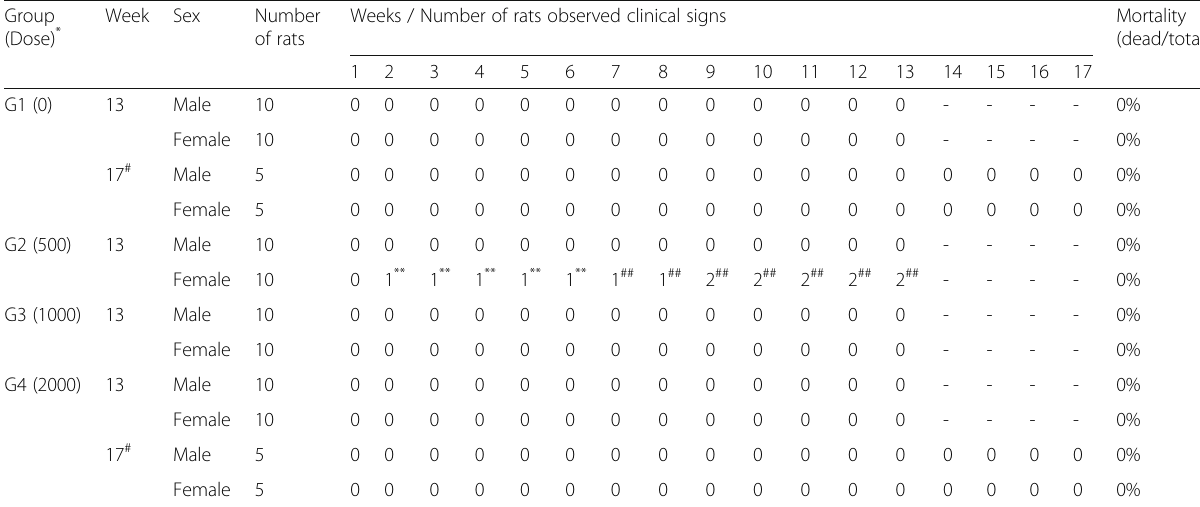
Table 4 Clinical signs observed in the 13-week repeated oral dose toxicity study with SD rats Group Week Sex Number (Dose) * of